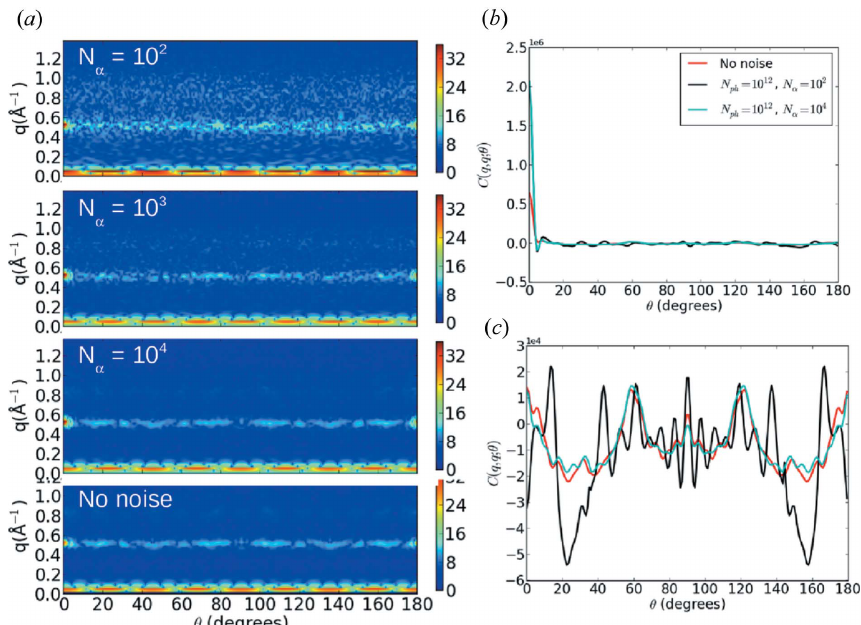
Figure 4 ( a ) The effect of noise on a cross-section of the intensity correlation function C ( q = 0.5 A˚ (cid:3) 1 , q 0 , (cid:2) ) varying the number of patterns. Noise is clearly visible ¼ 10 2 , but is suppressed by N ¼ 10 4 except for a large peak at (cid:2) ¼ 0 which arises from the self-correlation of the shot noise with itself. ( b ) A line for N (cid:3) (cid:3) plot of q = q 0 = 0.5 A˚ (cid:3) 1 which shows that the peak at (cid:2) ¼ 0 varies with the noise level. This peak can be removed with a centrosymmetric filter that replaces information in the vicinity of (cid:2) = 0 (cid:11) with the information near (cid:2) = 180 (cid:11) . ( c ) After applying the centrosymmetric filter, the N well with the noise-free simulation for the full range of (cid:2)